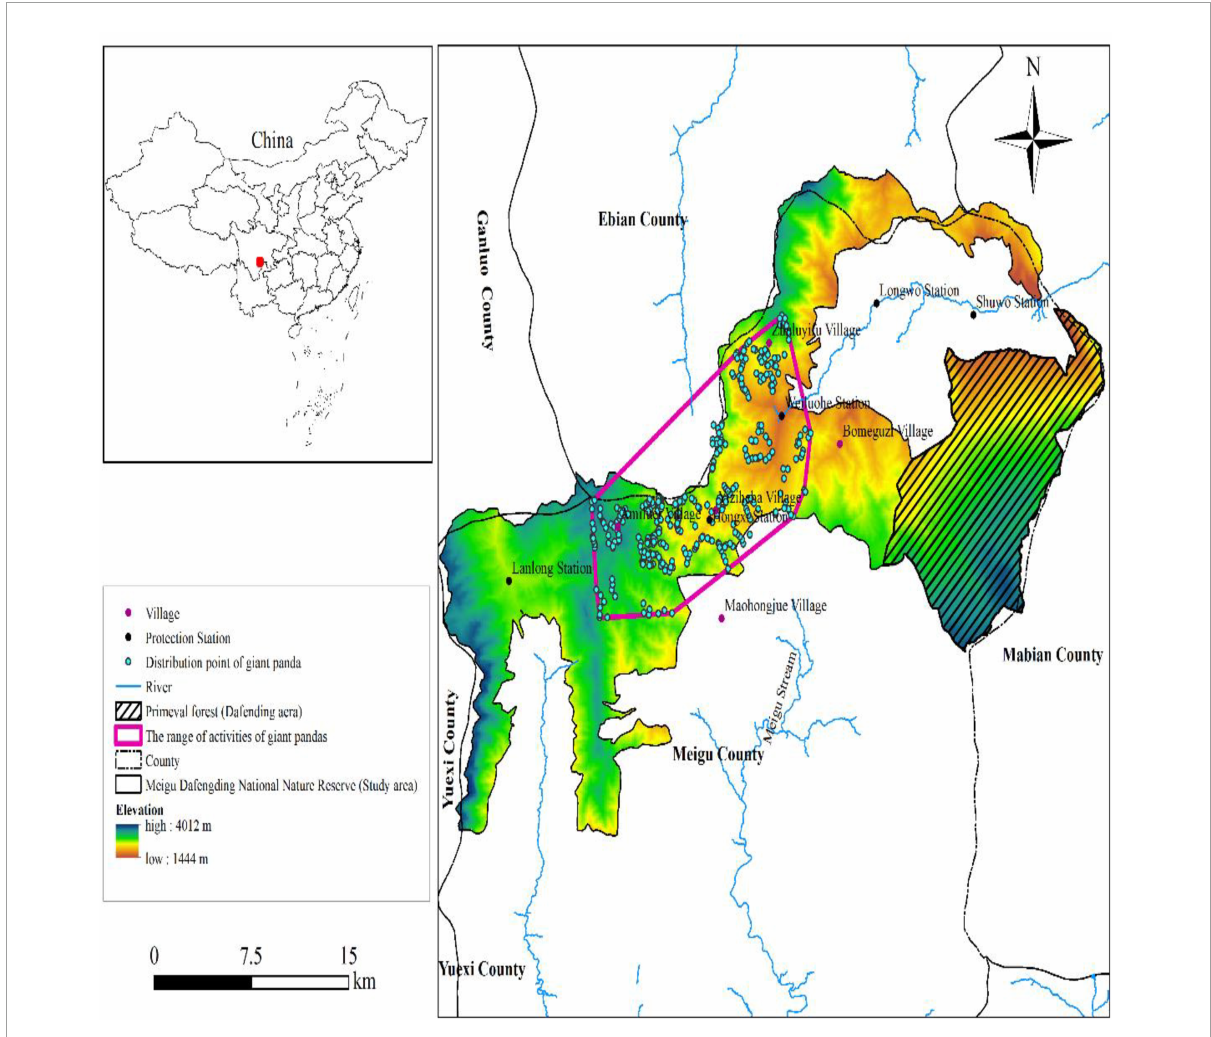
FIGURE1 Distribution map of Meigu Dafengding National Nature Reserve and population distribution sites of the giant